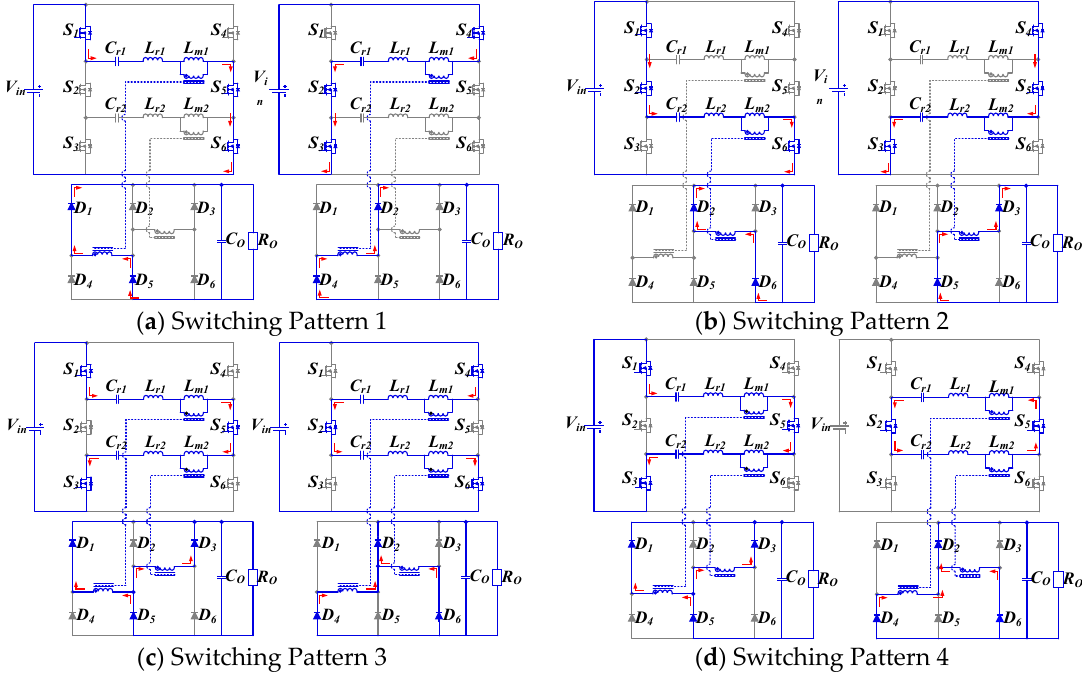
Figure 2. The current paths depending on the switching patterns (Patterns 1~4).